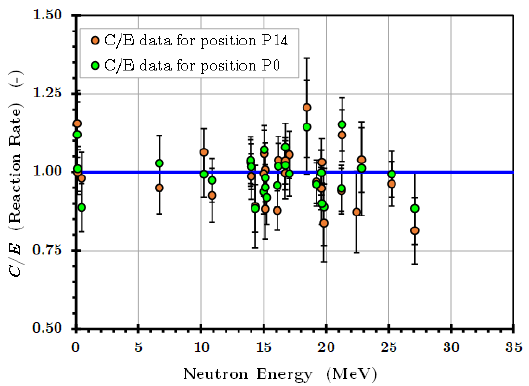
Figure 5. Calculated-to-experimental reaction rates ratios for in- vestigated positions P0 and P14.